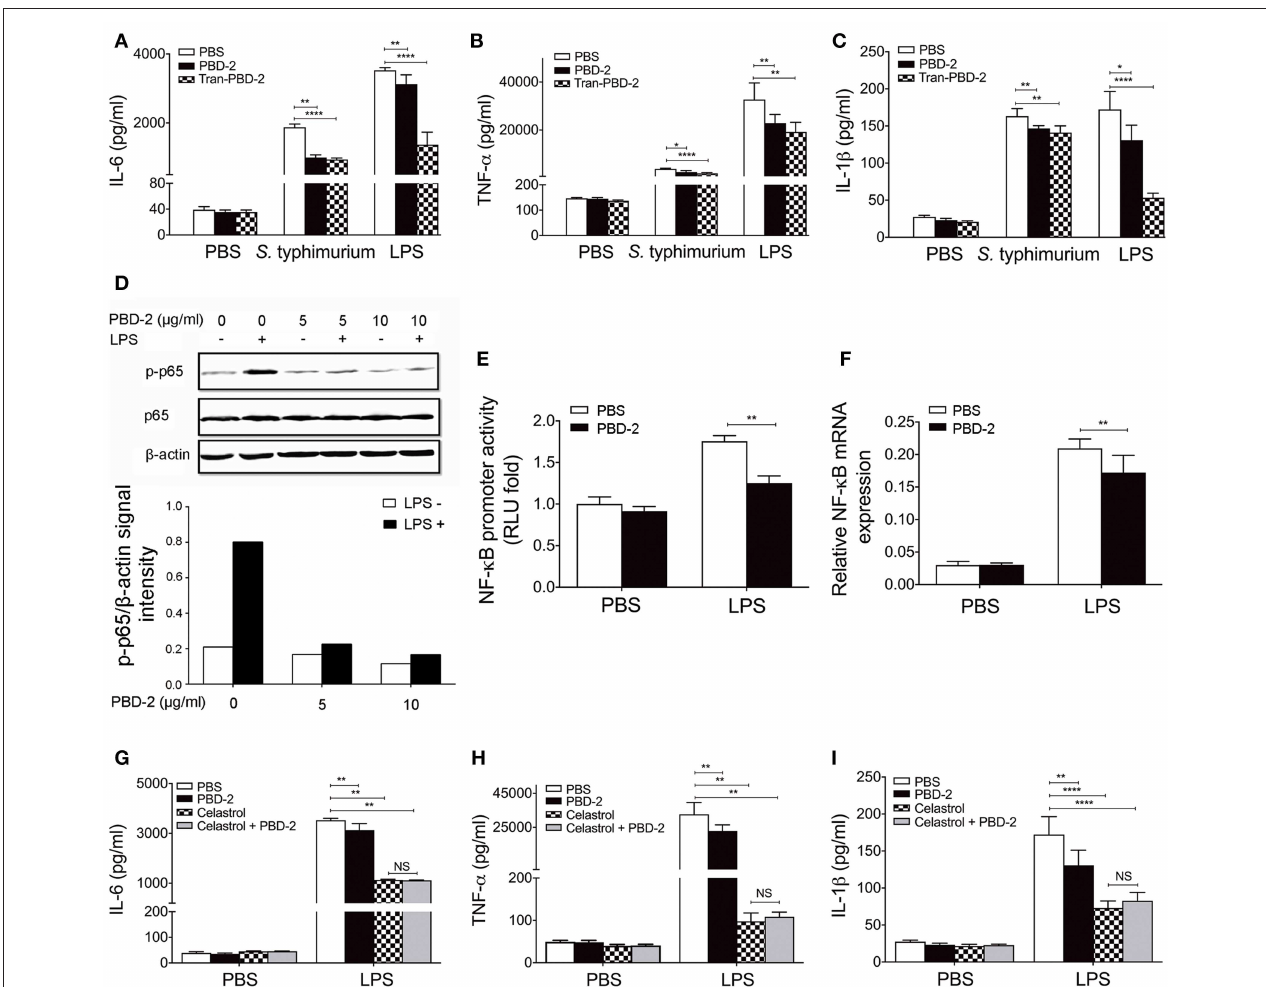
FIGURE 5 | PBD-2 inhibited LPS-induced inflammation via NF- κ B signaling pathway. (A–C) Levels of proinflammatory cytokines in the supernatants of RAW 264.7, RAW 264.7 supplemented with PBD-2 or RAW 264.7 expressing PBD-2 (Tans-PBD-2 RAW 264.7) after treatment with S. Typhimurium or the stimuli LPS. Cells treated with PBS were used as negative control. (D) Cells were treated with LPS with or without various concentrations of PBD-2, then expression of p65 and p-p65 was examined by Western blot (upper). The signal intensity of each band was quantified (lower). (E) Cells were incubated with LPS alone or with PBD-2. The NF- κ B promoter activity was detected by luciferase reporter assay. Results are presented as fold induction of luciferase compared with negative control. Cells treated with PBS were used as negative control. (F) Cells were incubated with LPS alone or with PBD-2, and the mRNA levels of NF- κ B were detected by RT-PCR. (G–I) RAW 264.7 cells were pre-treated with NF- κ B -inhibitor (Celastrol), then the cells were treated with LPS alone or together with PBD-2. Cells treated with PBS were used as negative control. Levels of proinflammatory cytokines in the supernatants of the cells were detected. All data are represented as means ± SD ( n = 6 each group). NS, p > 0.05, * p < 0.05, ** p < 0.01, **** p <